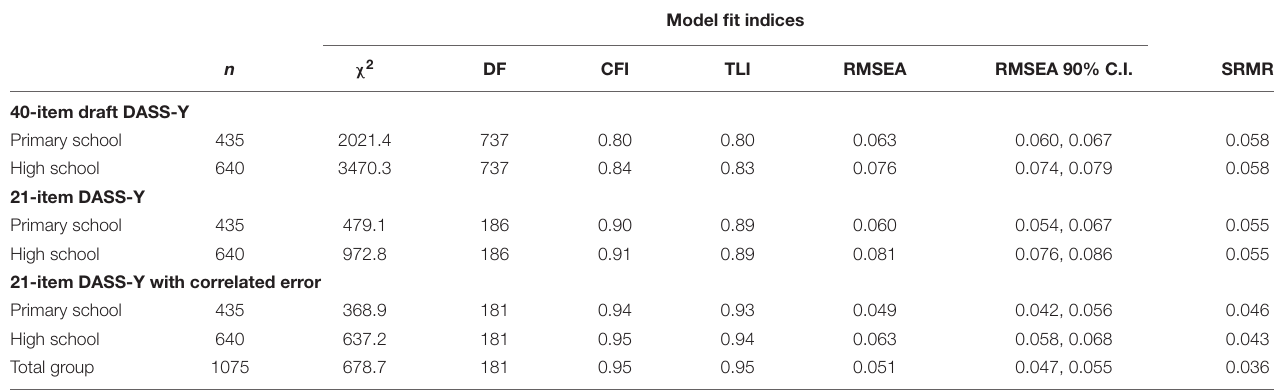
TABLE 3 | Model fit indices for the 40-item draft and the 21-item final DASS-Y models in the calibration sample ( N =